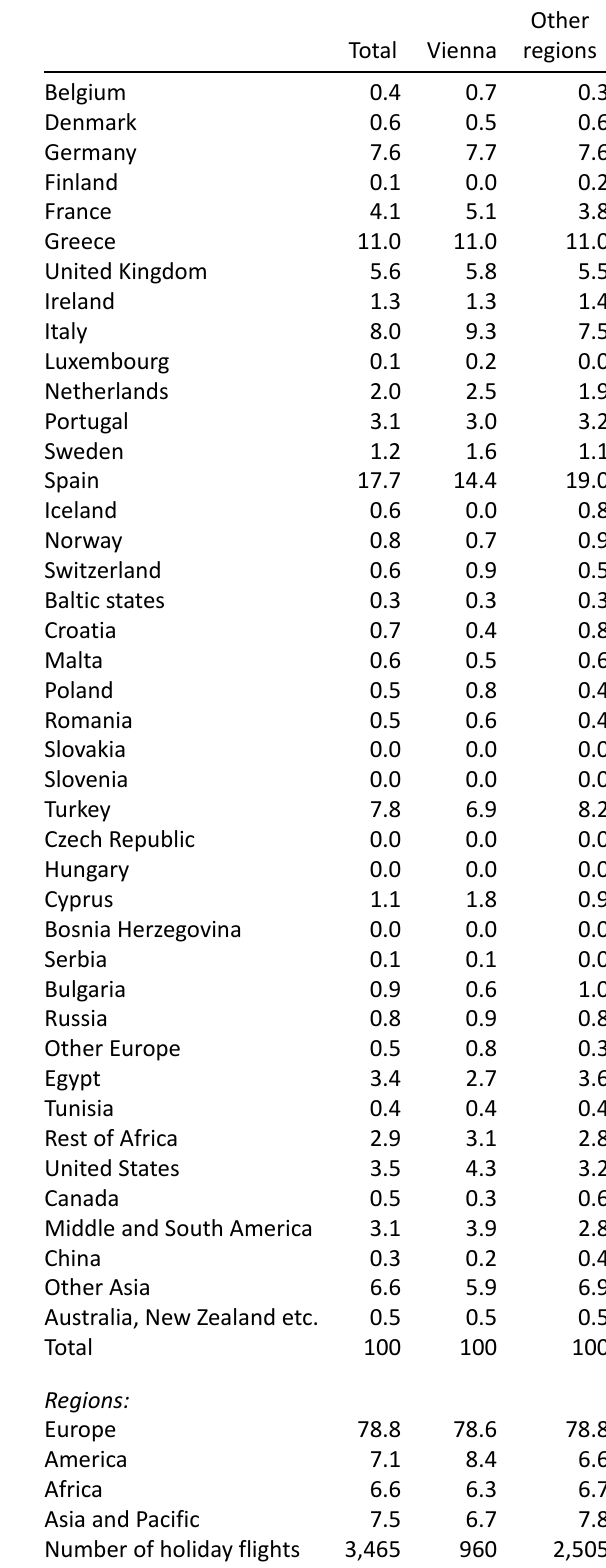
Table 2. Individual holiday flying behaviour by character‐ istics (per quarter).